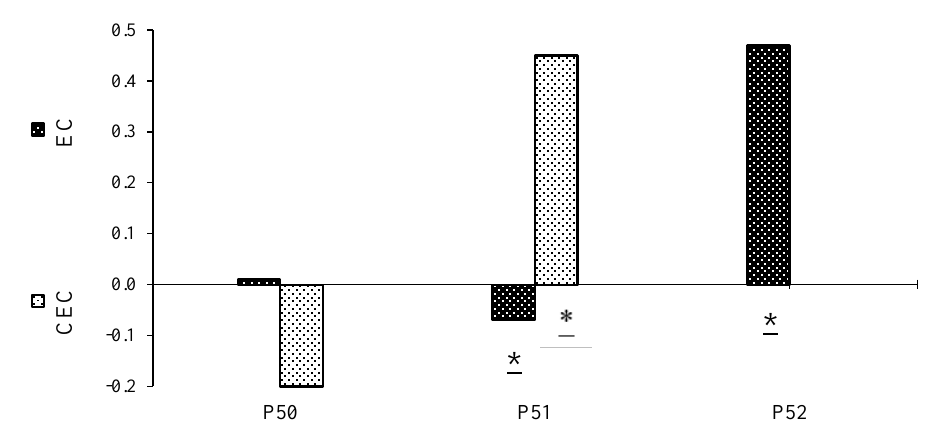
Figure 2. Electrical conductivity (dS · m − 1 ) and cation exchange capacity (cmol · kg − 1 ). Di ff erence t f − t 0 . * Statistically significant di ff erence.